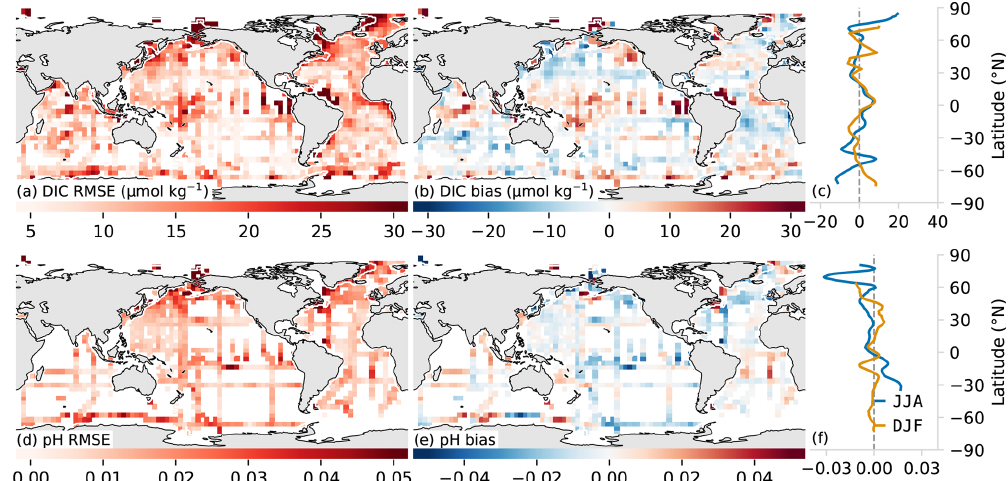
Figure 5. Root mean squared error (RMSE – a , d ) and biases (b, c, e, f) for dissolved inorganic carbon (DIC, a, b, c ) and pH (d, e, f) compared with in situ GLODAP v2.2019 data. The two subplots in the rightmost column compare the zonally averaged bias for JJA and DJF. Data were processed for plotting as described in Sect.